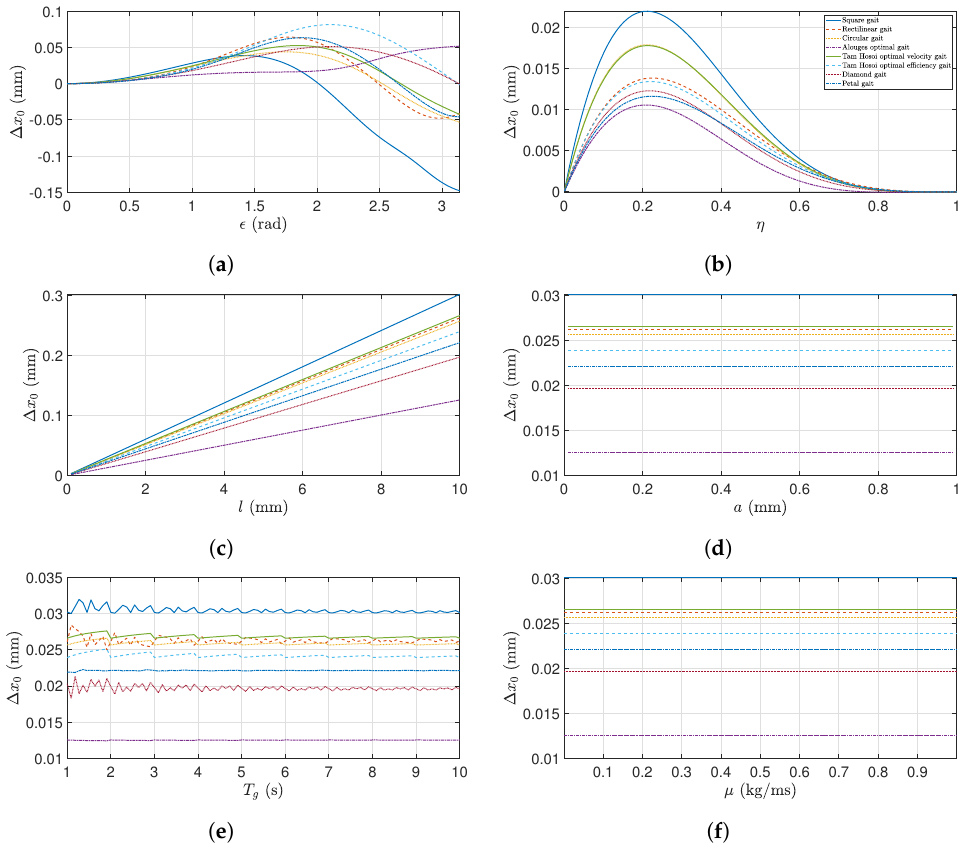
Figure 6. Displacement of the Purcell’s three-link swimmer depending on several parameters which may influence its movement: ( a ) amplitude of the gait ( (cid:101) ) ( b ) relation between lengths of the links ( η = l 0 / l ) ( c ) radius of the links ( a ) ( d ) total length of the swimmer ( l ) ( e ) gait period ( T g ) ( f ) viscosity of the fluid ( µ